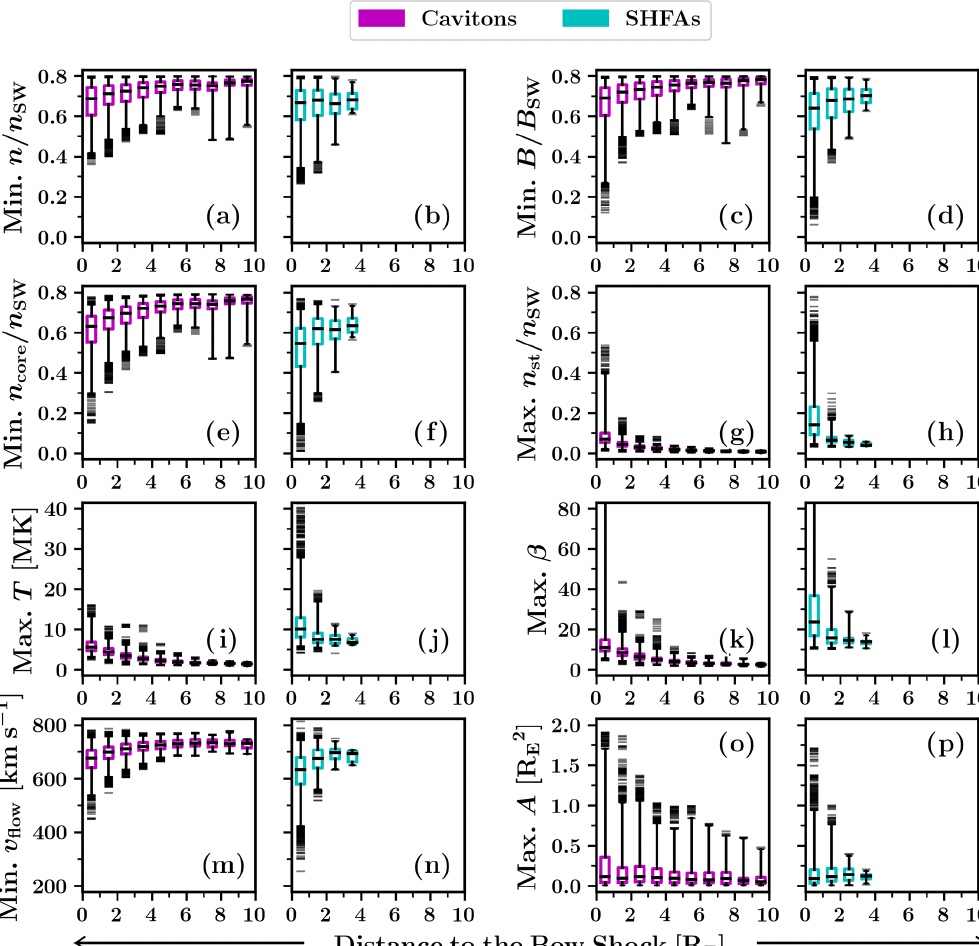
Figure 6. Box-and-whiskers plots showing the variation of the tracked transients’ physical properties with the distance from the bow shock (along the IMF direction). Each box covers an interval of 1 R E , showing the interquartile data range that contains 50% of the data around the median, which is shown as a black horizontal line. The whiskers extend to 1%/99% of the data, with outliers displayed as horizontal